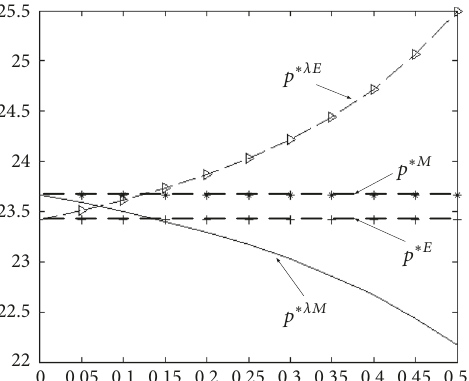
Figure 10: Change rule of network platform’s profit as 𝜆